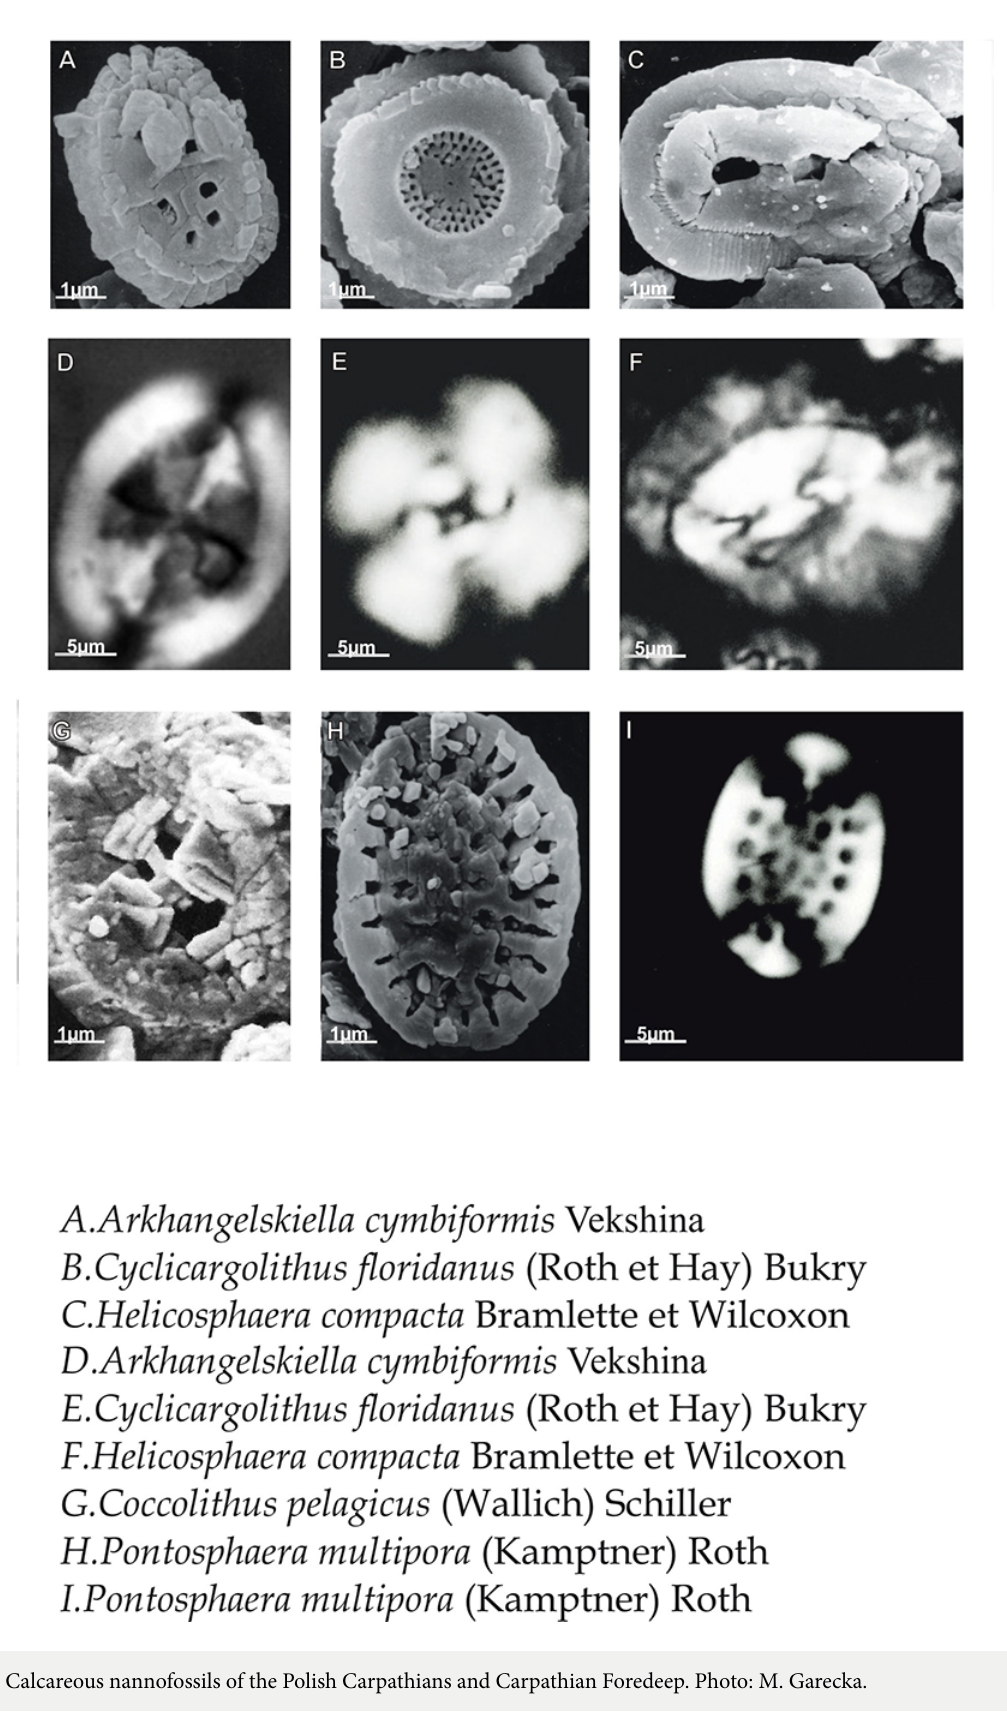
Figure 4 Calcareous nannofossils of the Polish Carpathians and Carpathian Foredeep. Photo: M. Garecka.